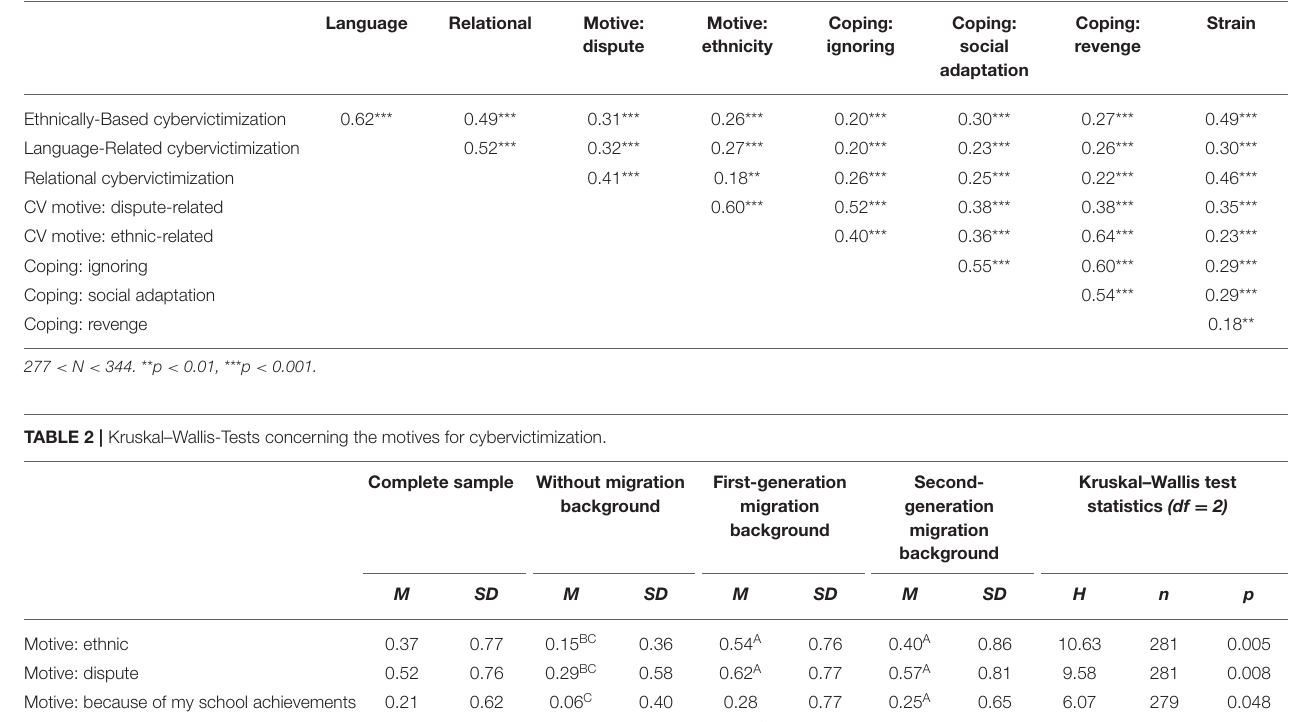
TABLE 1 | Correlations.